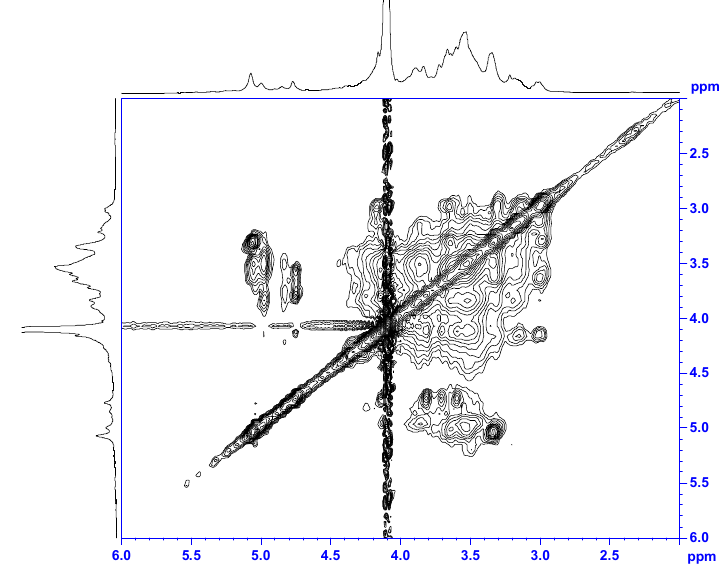
Figure 5. 2D 1 H- 1 H NOESY NMR correlation spectra of JSP fraction. The analyses were recorded at 40 g/L in D 2 O solution at 60 °C.